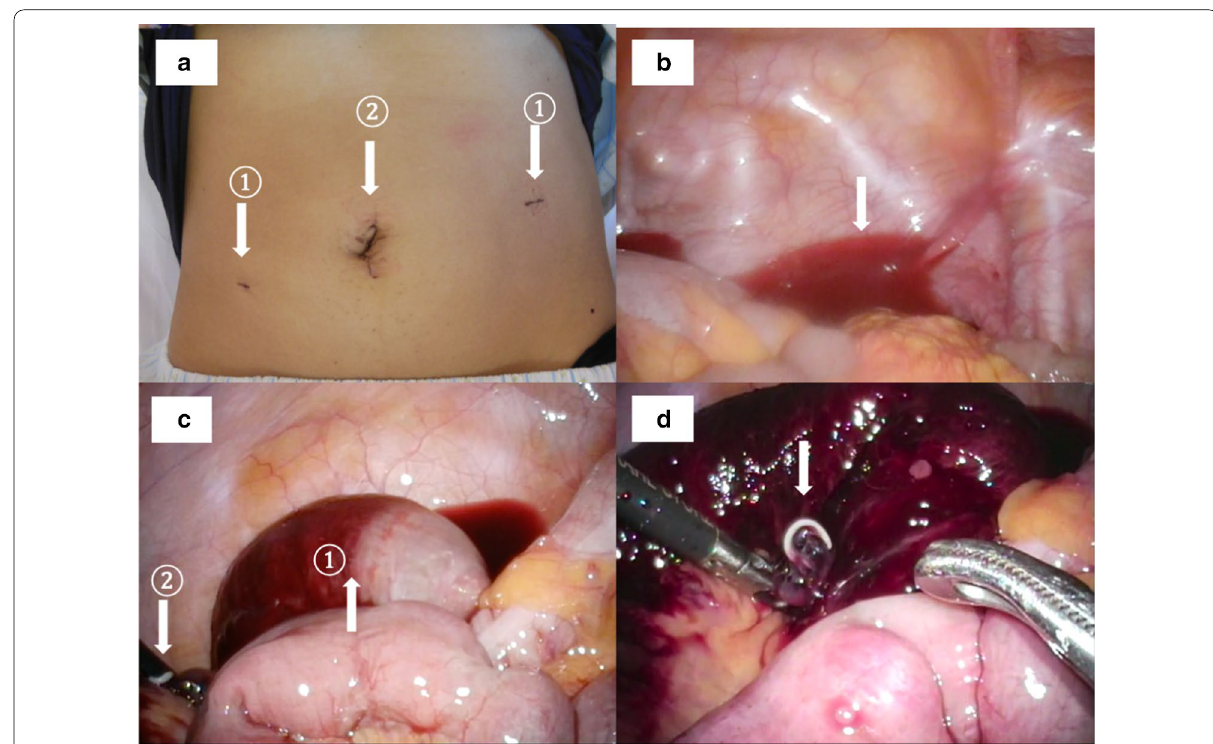
Fig. 2 Findings during operation. a Trocar arrangement in this procedure. Two 5 mm ports were placed on both sides ① . The 12 mm port was placed in the navel, and a small incision was made to resect the small intestine ② . b – d Laparoscopic exploration findings. b There were bloody ascites in the pouch of Douglas. c Severe local circulatory abnormalities were found in the ileum. There were no findings that caused strangulation ① . The Anisakis worm was found on the edge of screen ② . d A live larva had pierced the mesentery of the